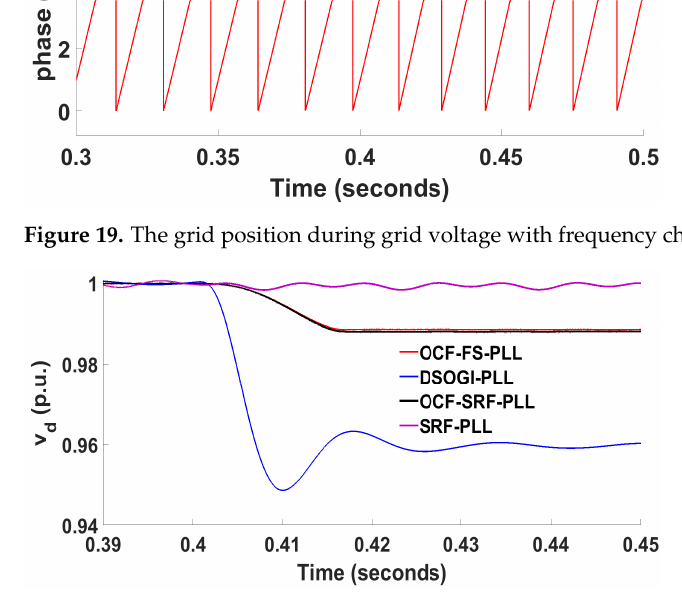
Figure 20. The v g , d of the positive sequence component during grid voltage with frequency